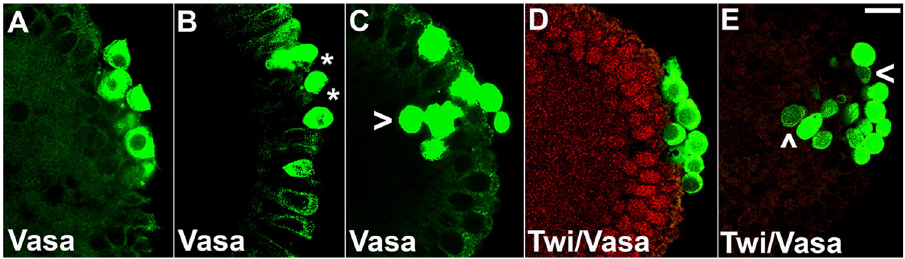
Fig 8. Loss of dpp function results in invasive migration and lack of adherence of PGCs. 0–4 hr paraformaldehyde- fixed (A) osk/+ (B/C) dpp hr92 /+;osk/+ (D) WT and (E) dpp 4 embryos were stained for Vasa (A-E, green) and Twist (D-E, red). Asterisks show spread of PGCs/lack of adherence in dpp hr92 /+;osk/+ embryos while carets highlight invasive migration in dpp hr92 /+;osk/+ and dpp 4 embryos. Images are representative maximum intensity projections. Scale bar represents 10 μ